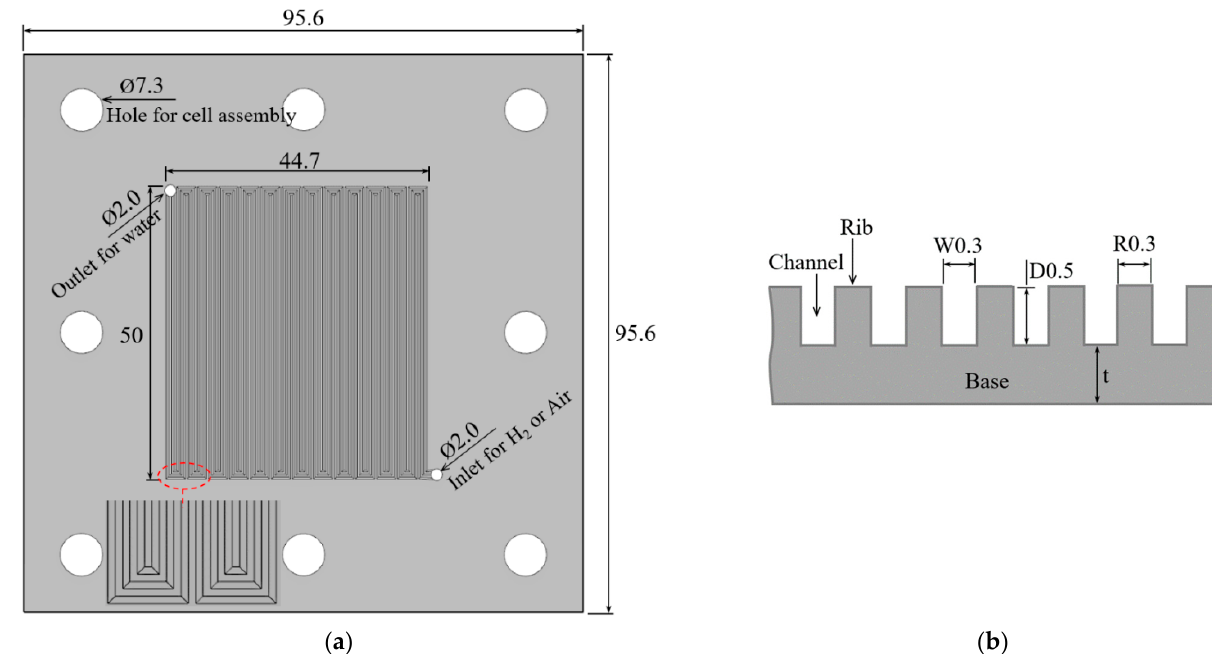
Figure 1. Design of the BP for PBF 3D printing: ( a ) planal view; ( b ) cross-sectional view. Channel width of 0.3 mm (W0.3), channel depth of 0.5 mm (D0.5), and rib of 0.3 mm (R0.3) (unit: mm).